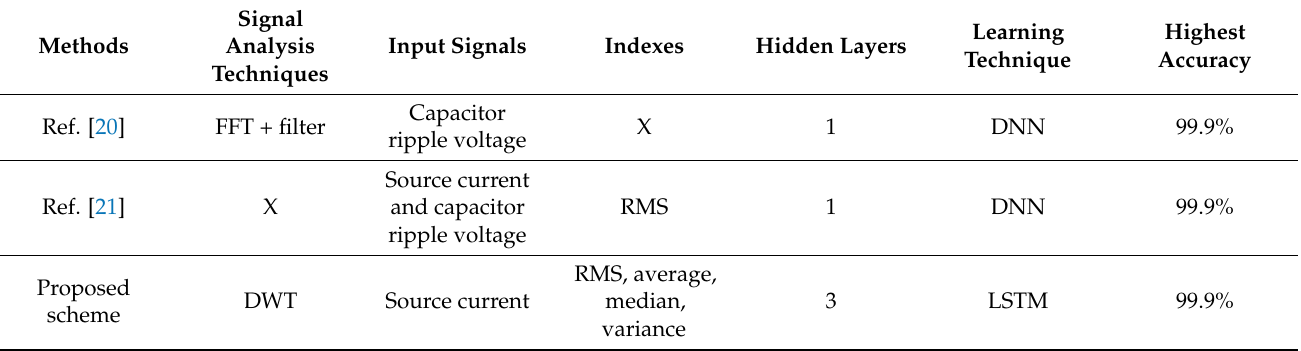
Table 6. Comparison to other